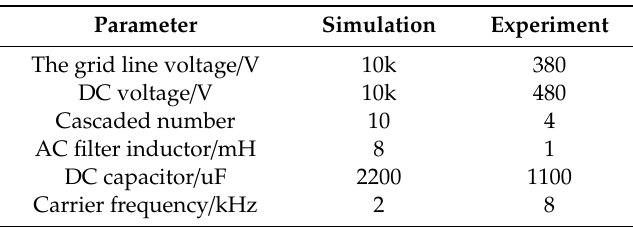
Table 1. Main parameters of the